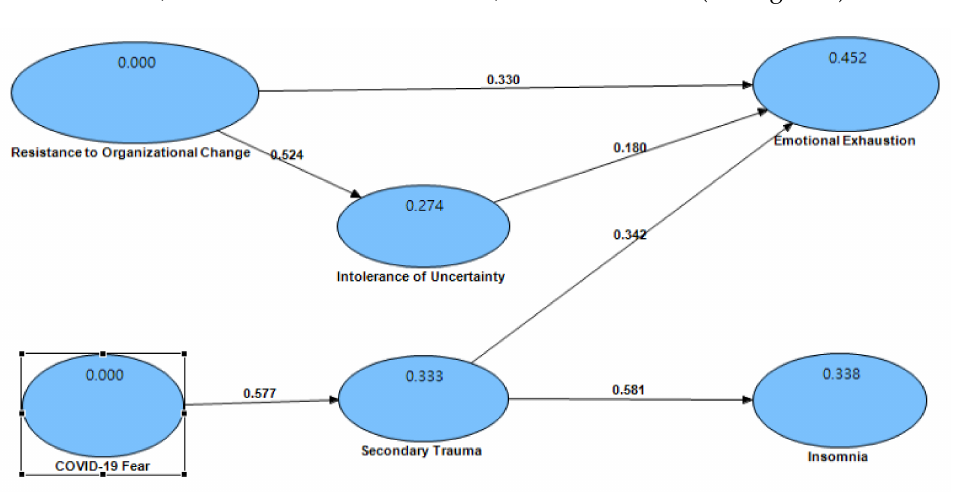
Figure 2. Causal coefficient